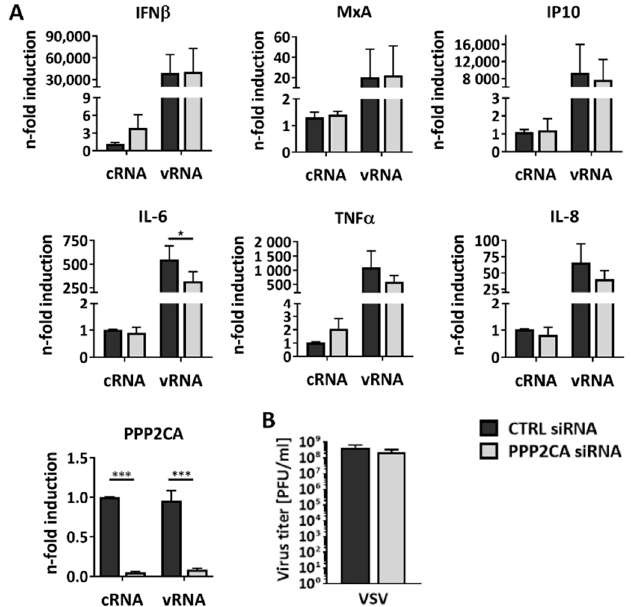
Figure 2. PP2A does not alter the IAV-induced antiviral innate immune response. ( A ) A549 cells were stimulated with previously isolated cellular RNA (cRNA) or viral RNA (vRNA) 48 h after siRNA-mediated KD of PP2Ac. Transcription of exemplary genes of the antiviral IFN-mediated and pro-inflammatory immune response were analyzed using quantitative real-time PCR. KD efficiency was analyzed by measurement of PP2Ac mRNA levels. ( B ) A549 cells were infected with VSV (MOI = 0.01) 48 h after siRNA-mediated KD of PP2Ac. Virus titers were analyzed using standard plaque assays. ( A , B ) Data are represented as means + SD of three independent experiments with three biological replicates. Statistical significance was analyzed using a two-way ANOVA ( A ) or unpaired two-tailed t-test ( B ) with * p < 0.05 and *** p < 0.001.